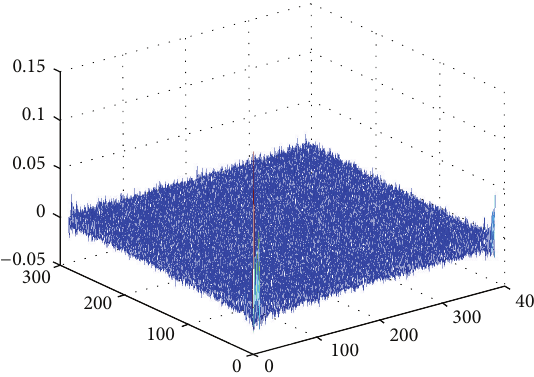
Figure 10: BLPOC function for IIT Delhi palmprint